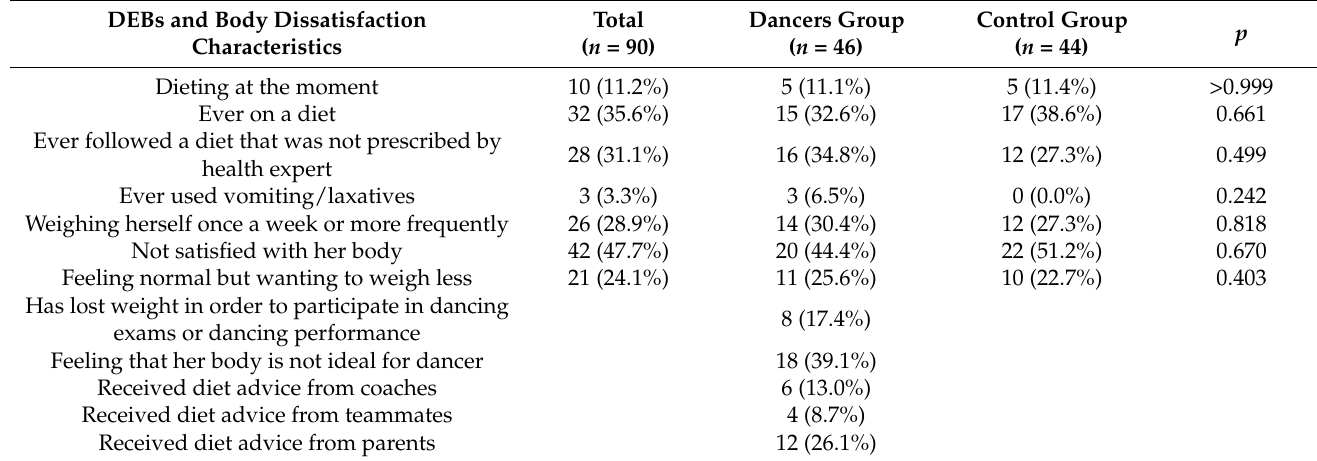
Table 6. DEBs and body dissatisfaction